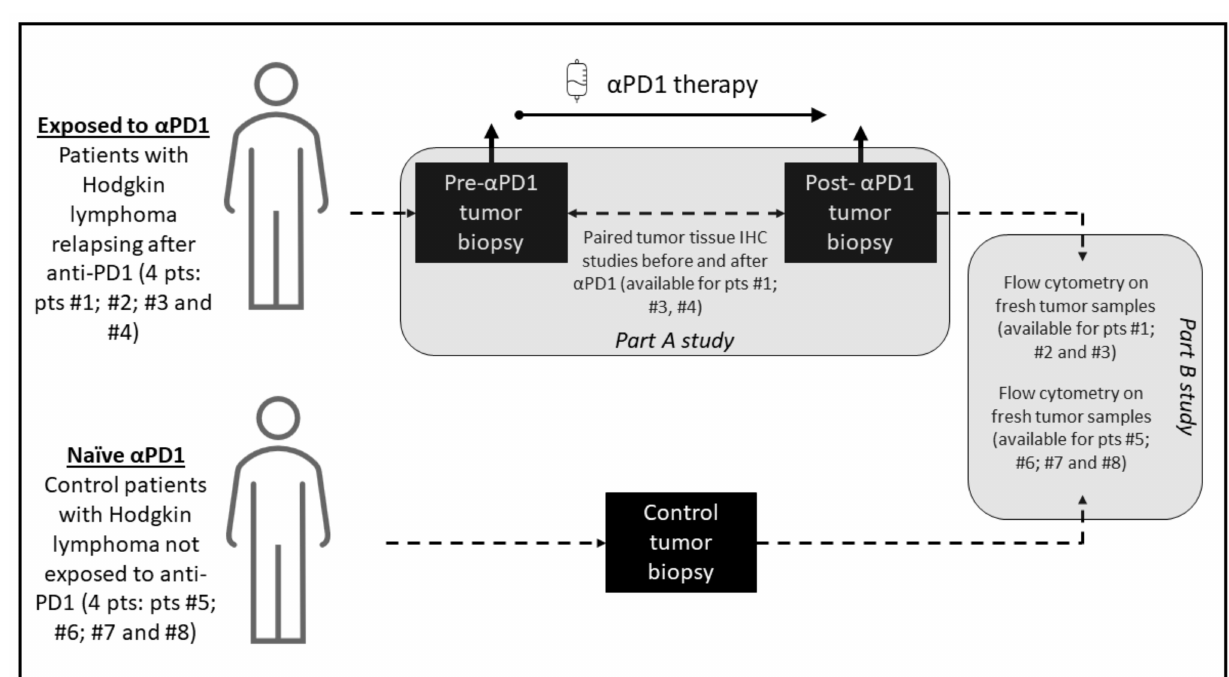
Figure 1. Graphical summary of the study methodology. The study consisted of two parts: part A, which was a paired study of tumor biopsies before and after anti-PD-1 exposure where each patient is his own control, and part B, which compared analyses on fresh cells of tumor microenvironment of patients exposed to anti-PD-1 and not exposed to